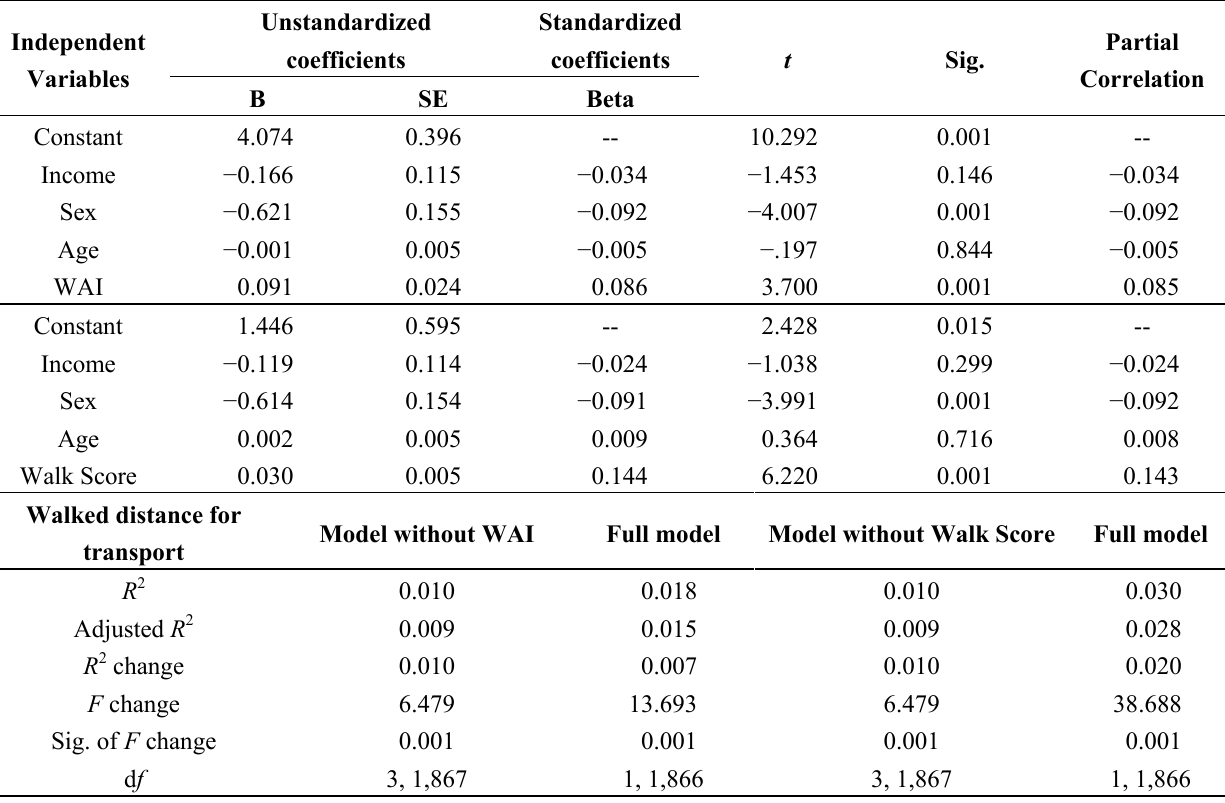
Table 3. Regression models for walked distance for transport per week with and without WAI and Walk Score.